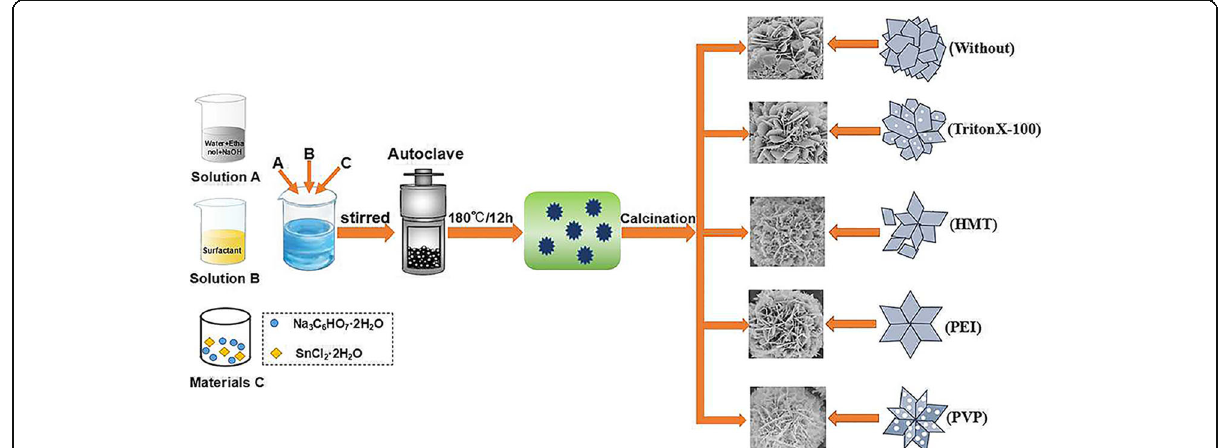
Fig. 1 Schematic illustration of the formation process of the hierarchical flower-like SnO 2 nanostructures using different kinds of